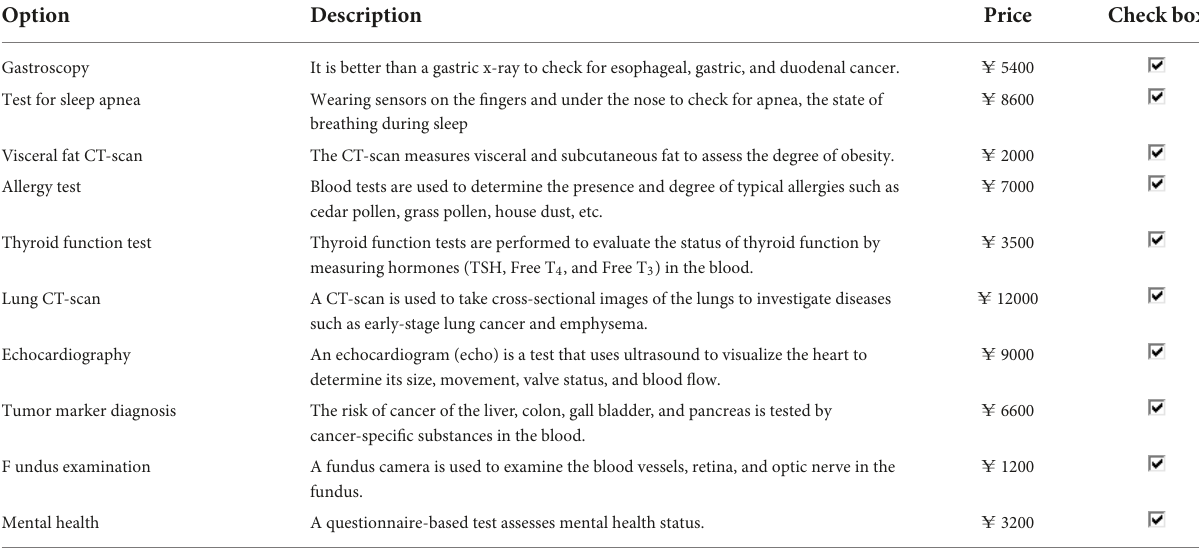
TABLE B Screen for choosing the medical examination options in -OF. Please uncheck the option if you do not need